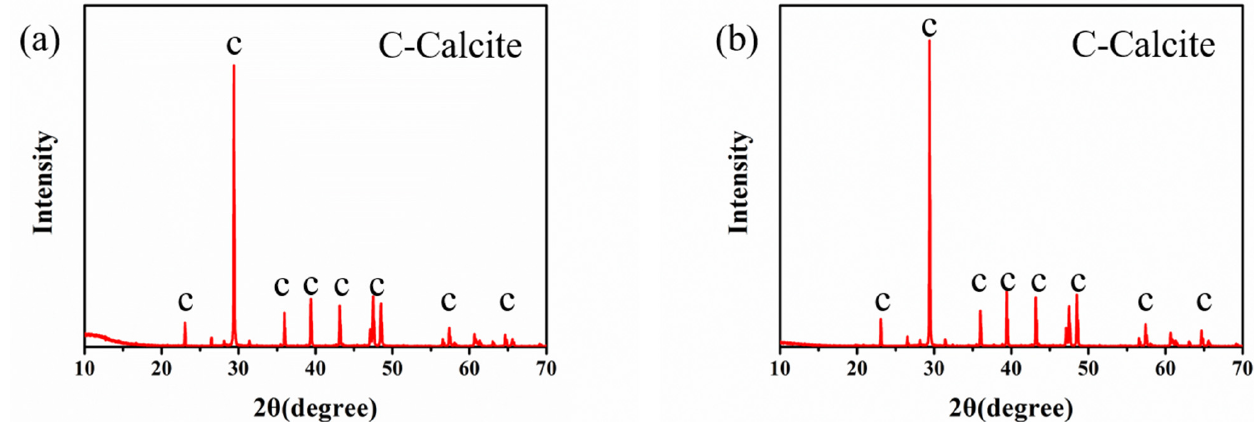
Figure 7. SEM images of CaCO 3 crystals with different quantities of TCS with 0.25% Na-MMT (TCS = 100 ( a ), 200 ( b ), 300 ( c ), and 300 g ( d )).